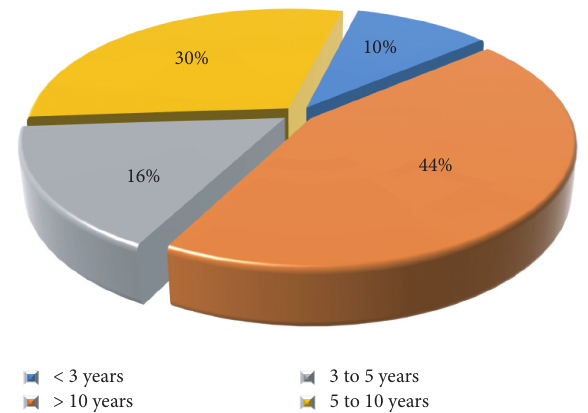
Figure 13: The period of experience rate of the population consulted.